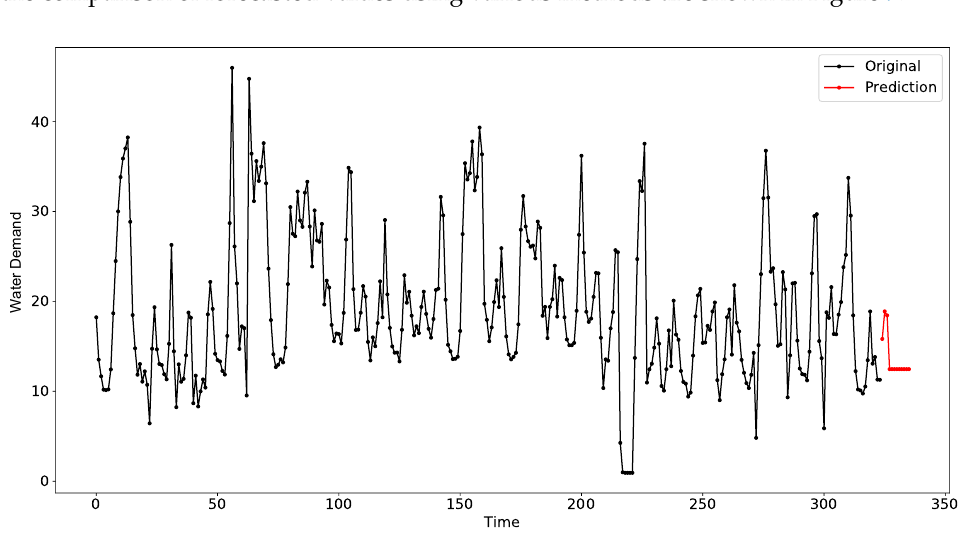
Figure 7. Result of psf_plot() for the “Water Demand”